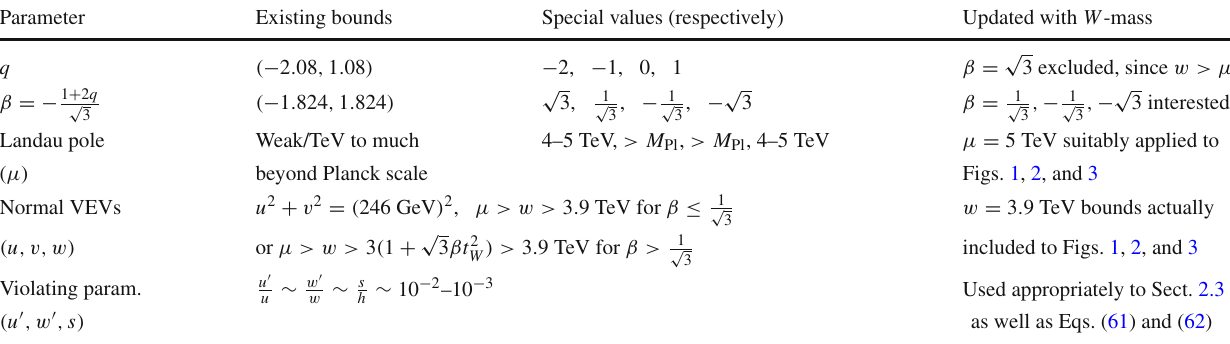
Table 2 A summary of existing bounds and their updates with W -mass result Parameter Existing bounds Special values (respectively) Updated with W -mass